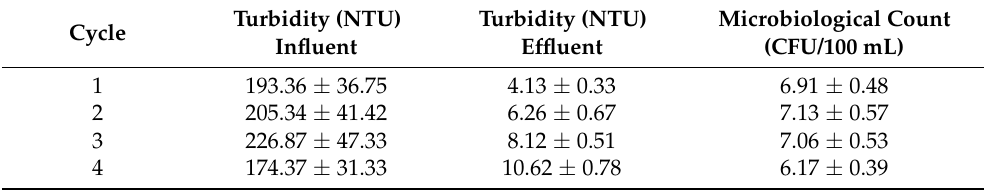
Table 6. Turbidity and E. coli